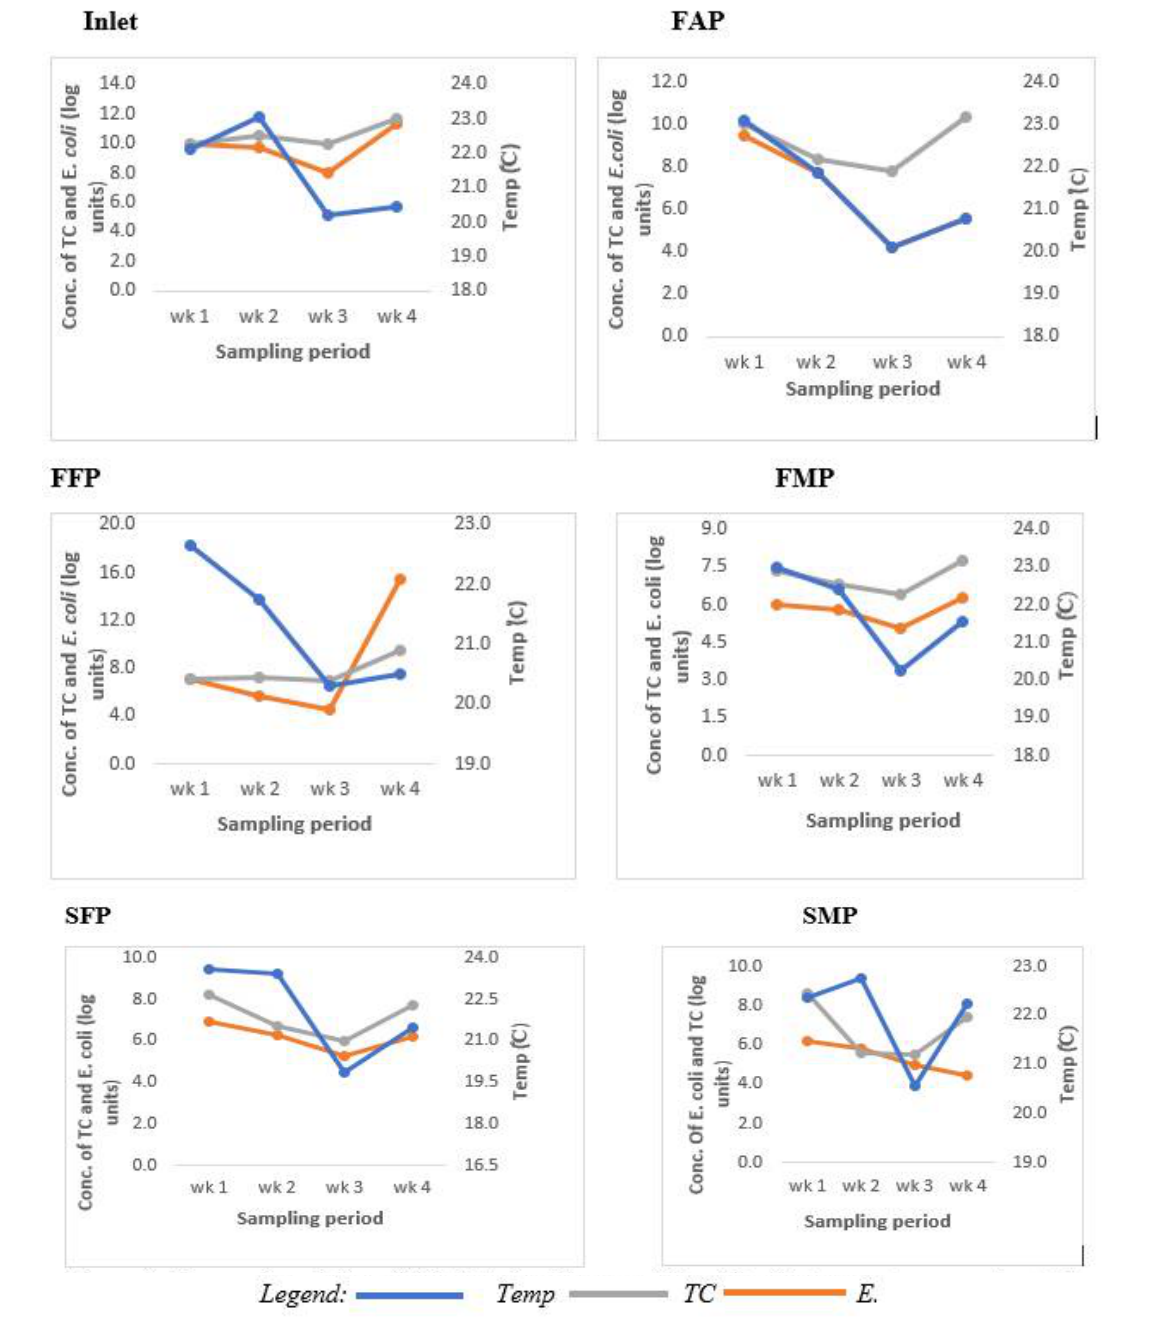
Figure 4: Temporal variation of FIB (Total coliforms and E. coli ) with temperature over the study period in the wastewater stabilization ponds. Faecal Indicator Bacteria counts are represented as log units, temperature (°C) and sampling period in weeks (weeks 1 to 4). Key: FAP = First Anaerobic Pond, FFP = First Facultative Pond, FMP = First Maturation Pond, SFP = Second Facultative Pond, and SMP = Second Maturation